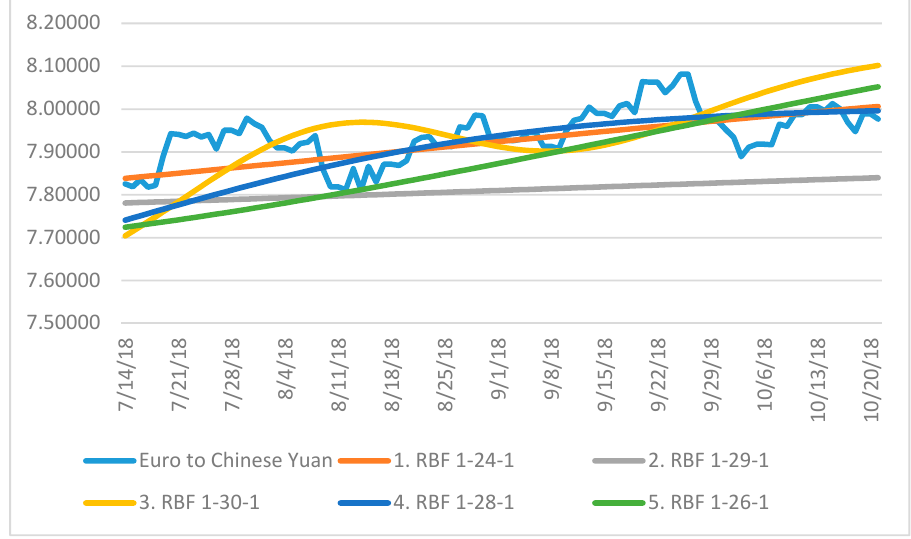
Figure 5. Line graph—development of the Euro to Yuan exchange rate predicted by neural networks compared to the actual exchange rate between 14th July and 21st October 2018. (Source: Own